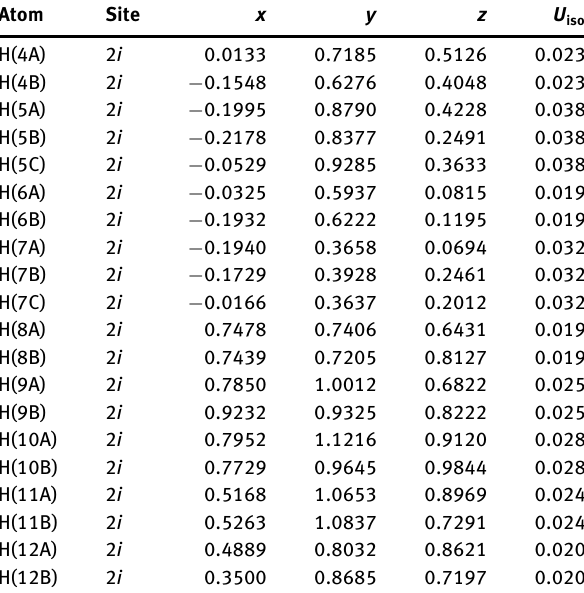
Table 2: Fractional atomic coordinates and isotropic or equivalent isotropic displacement parameters (Å 2